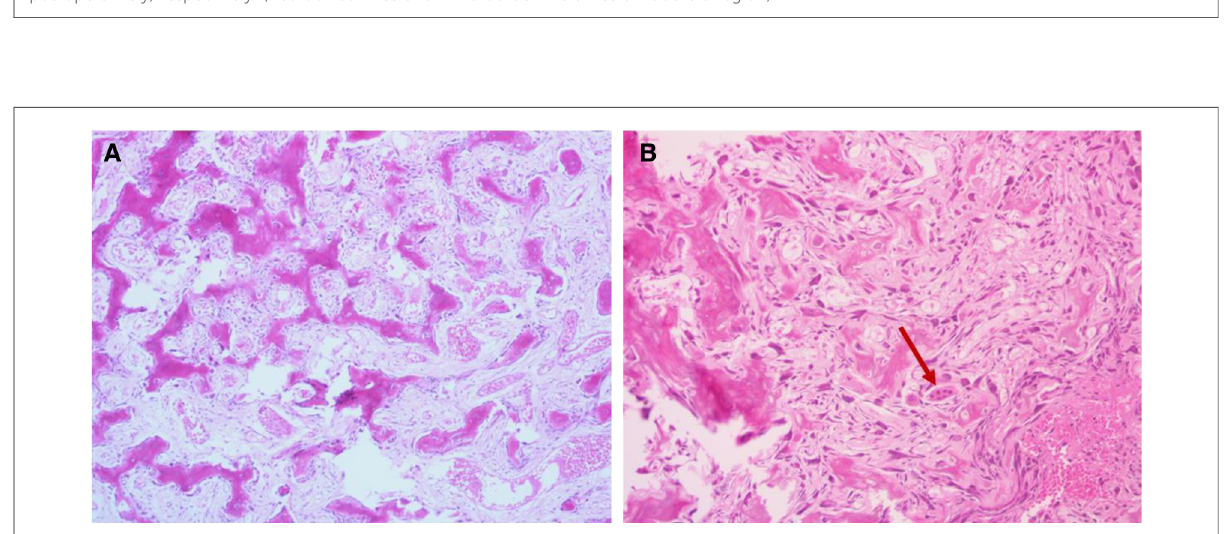
FIGURE 2 Surgical intervention and radiological change in CBCT images: (A) lesion resection at the left articular tubercle; (B) stitches of the incision and high vacuum drainage device placement; (C – E) CBCT images of the lesion area preoperatively, immediately postoperatively and one month postoperatively, respectively. (Red dotted lines show the border the articular tubercle region).